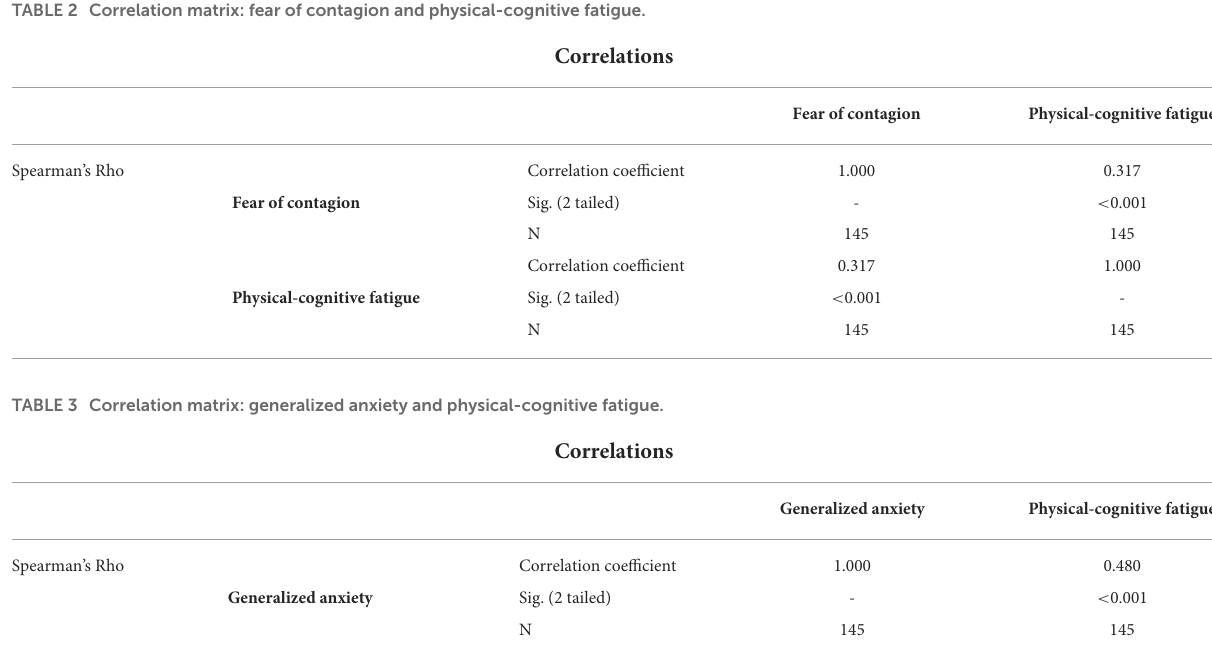
TABLE 2 Correlation matrix: fear of contagion and physical-cognitive fatigue.